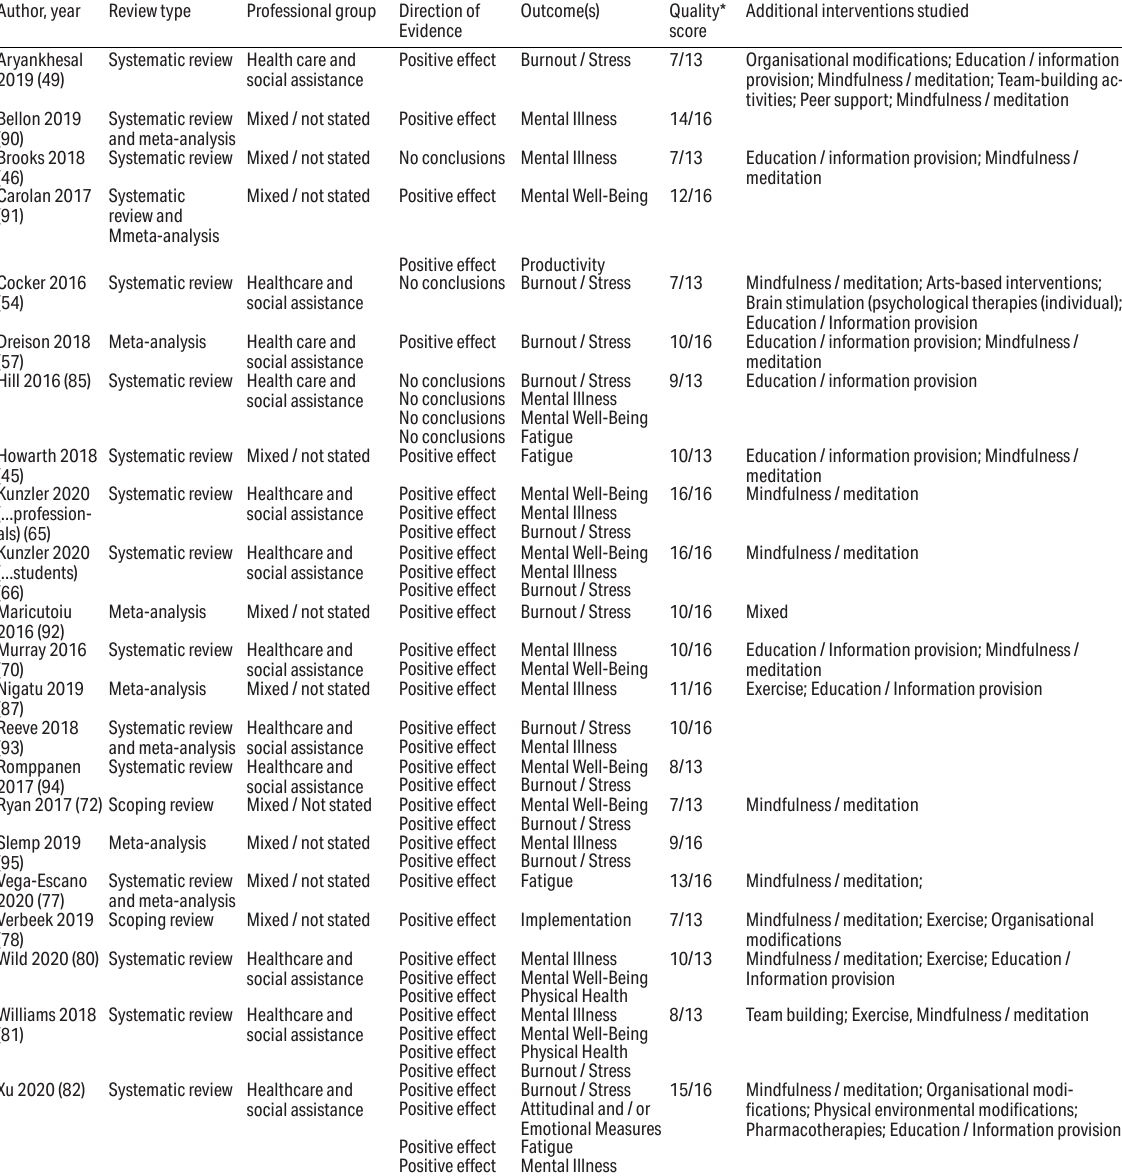
Table 3. High quality reviews of psychological